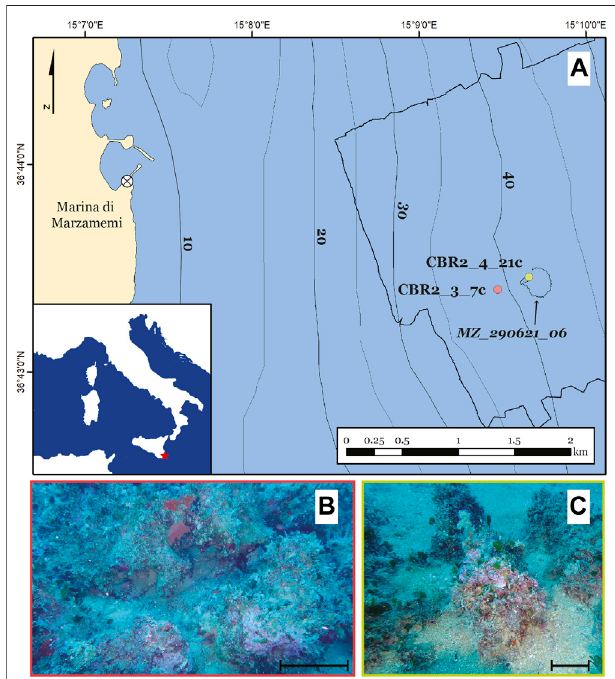
FIGURE 1 | Location of the study area and the sampling sites. (A) Bathymetric map of the study area, Marzamemi, Sicily, with the indication of the ROV_290621_06 track (black line) and the sampling sites (CBR2_3_7c, red dot and CBR2_4_21c, yellow dot). (B) Image from the ROV_290621_06 in a setting similar to the sampling site CBR2_3_7c. (C) Image from the ROV_290621_06 in a setting similar to the sampling